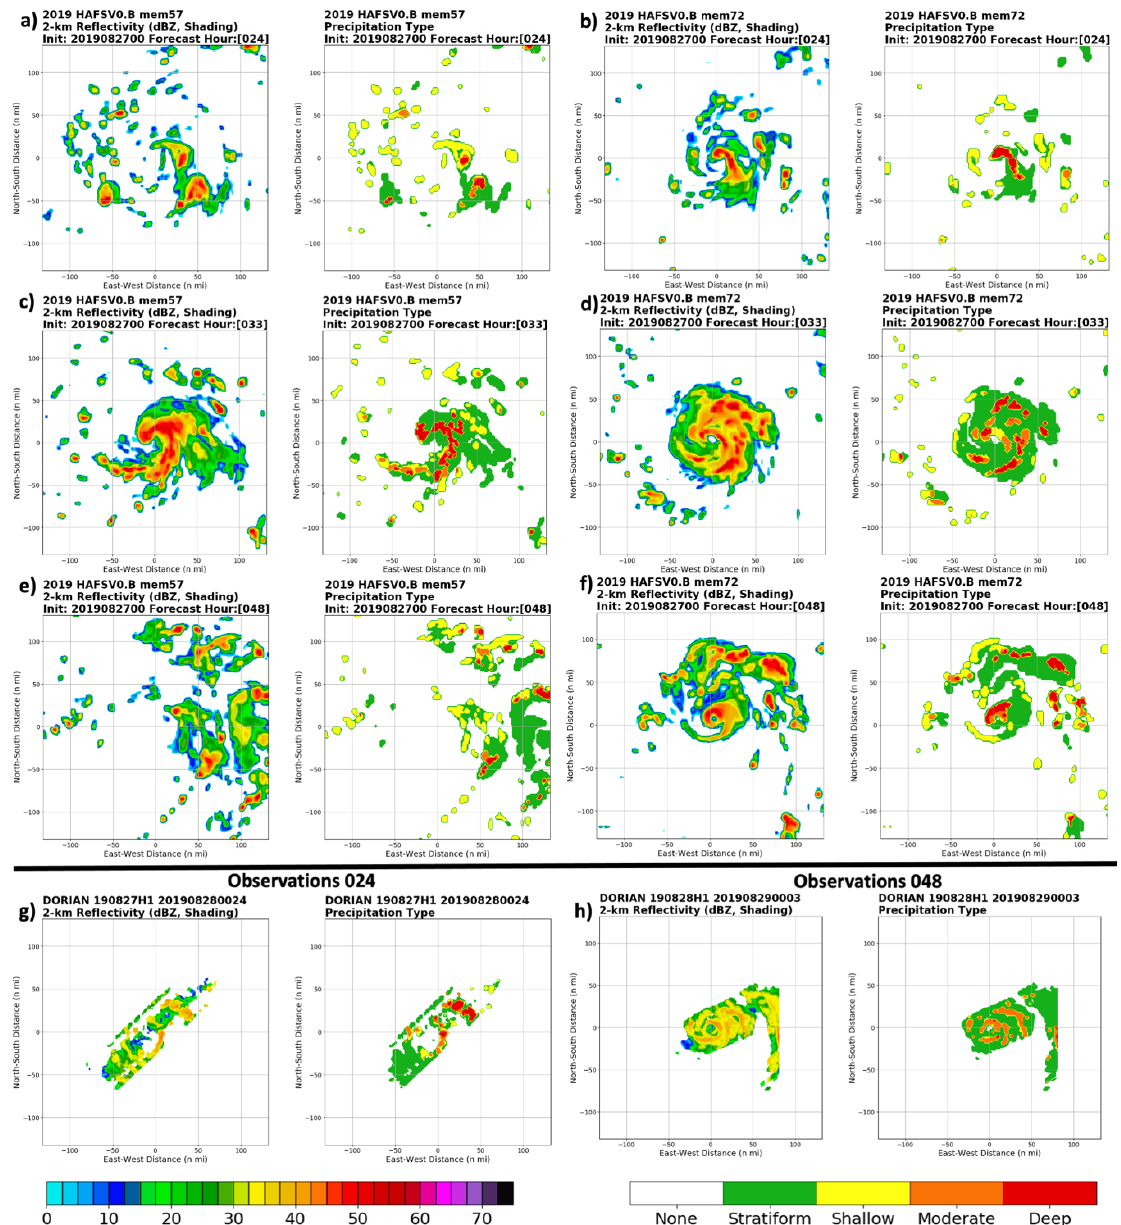
Figure 16. ( a ) Left—HAFS simulated reflectivity (dBZ) at z = 2 km for the weak member at 24 h. Right—HAFS precipitation type derived from simulated reflectivity for the weak member at 24 h. ( b ) As in ( a ), but for the strong member. ( c ) As in ( a ), but for 33 h. ( d ) As in ( b ), but for 33 h. ( e ) As in ( a ), but for 48 h. ( f ) As in ( b ), but for 48 h. ( g ) Observed NOAA P-3 radar reflectivity and precipitation type from a swath across Dorian at 0024 UTC 28 August. ( h ) As in ( g ), but for 0003 UTC 29 August.